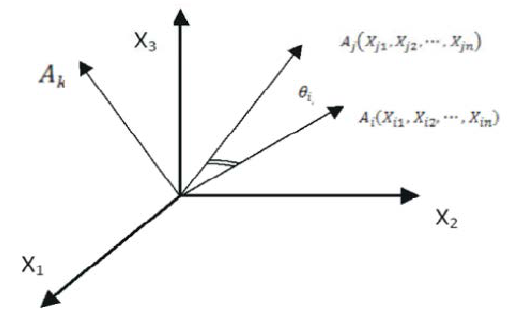
Fig.1. Degree of conflict between